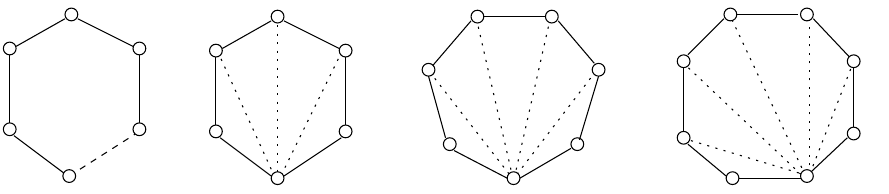
Figure 4. The forbidden subgraphs of graphs having stretch number less than 2. Dashed (dot- ted, respectively) lines represent paths of length at least one (chords that may or may not exist,